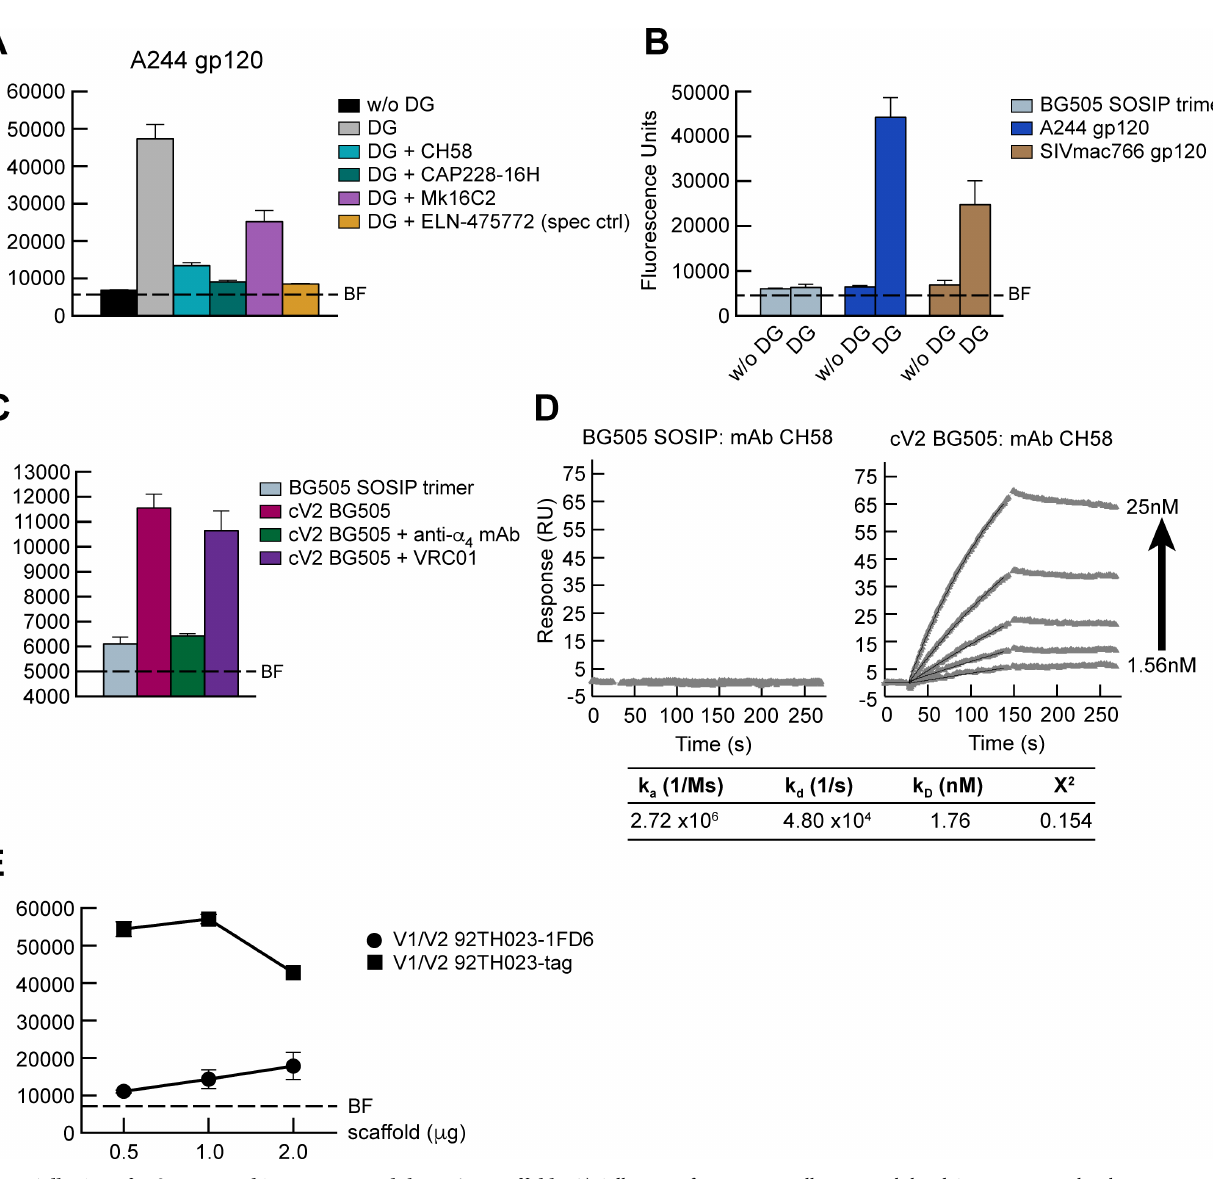
Fig 4. Adhesion of α 4 β 7 to recombinant gp120 and the V1/V2 scaffolds. A) Adhesion of RPMI8866 cells to immobilized A244 gp120 in the absence or presence of HIV V2-specific mAbs: CH58, CAP228-16H, and Mk16C2. The LDV mimetic ELN-475772 provides a specificity control for adhesion to α 4 β 7 . Adhesion was determined by OD 590nm and listed as fluorescence units (y-axis). Conditions are run in triplicate and error bars indicate SEM. Background fluorescence (BF) of RPMI8866 cells is denoted by a dashed line. Deglycosylation (DG) of A244 gp120 as indicated. Results from three or more independent experiments are shown in S4 Fig. B) Comparison of α 4 β 7 adhesion to glycosylated vs. DG forms of BG505 SOSIP trimer, A244 gp120, and SIVmac766 gp120 as described in panel A. Conditions are run in triplicate and error bars indicate SEM. BF is denoted by a dashed line. DG as indicated. Results from three independent experiments are shown in S5 Fig. C) Comparison of adhesion of RPMI8866 cells to BG505 SOSIP vs. cV2 BG505 peptide as described for panel A. The anti- α 4 mAb 2B4 is employed as a positive control and the gp120 mAb VRC01 is employed as a negative control. Error bars indicate SEM. This result is representative of three or more independent experiments as shown in S6 Fig. D) SPR analysis showing increasing concentrations of mAb CH58 (2-fold increases from 1.56 nM-25 nM) binding to BG505 SOSIP and cV2 BG505 coated surfaces. The parameters for the binding kinetics for cV2 BG505 are listed. E) Comparison of adhesion of RPMI8866 cells to V1/V2 92TH023-1FD6 vs. V1/V2 92TH023-tag scaffolds using increasing concentrations of each scaffold as indicated (x-axis). Adhesion was determined as describe for panel A. Conditions are run in triplicate and error bars indicate SEM. Results are representative of three independent